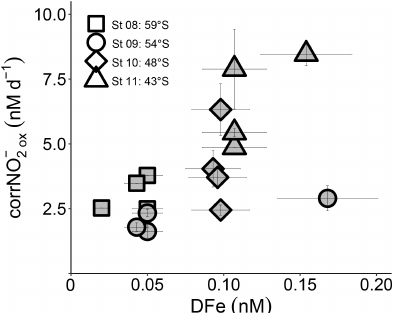
Figure 5. Euphotic zone (0–75m) revised rates of NO − ) measured at the depth-profile stations (St 08 to St 11) (corrNO − 2 ox plotted against coincident dissolved iron concentrations ([DFe]). Er- ror bars indicate the range of measured values. Where errors bars are not visible, they are smaller than the data